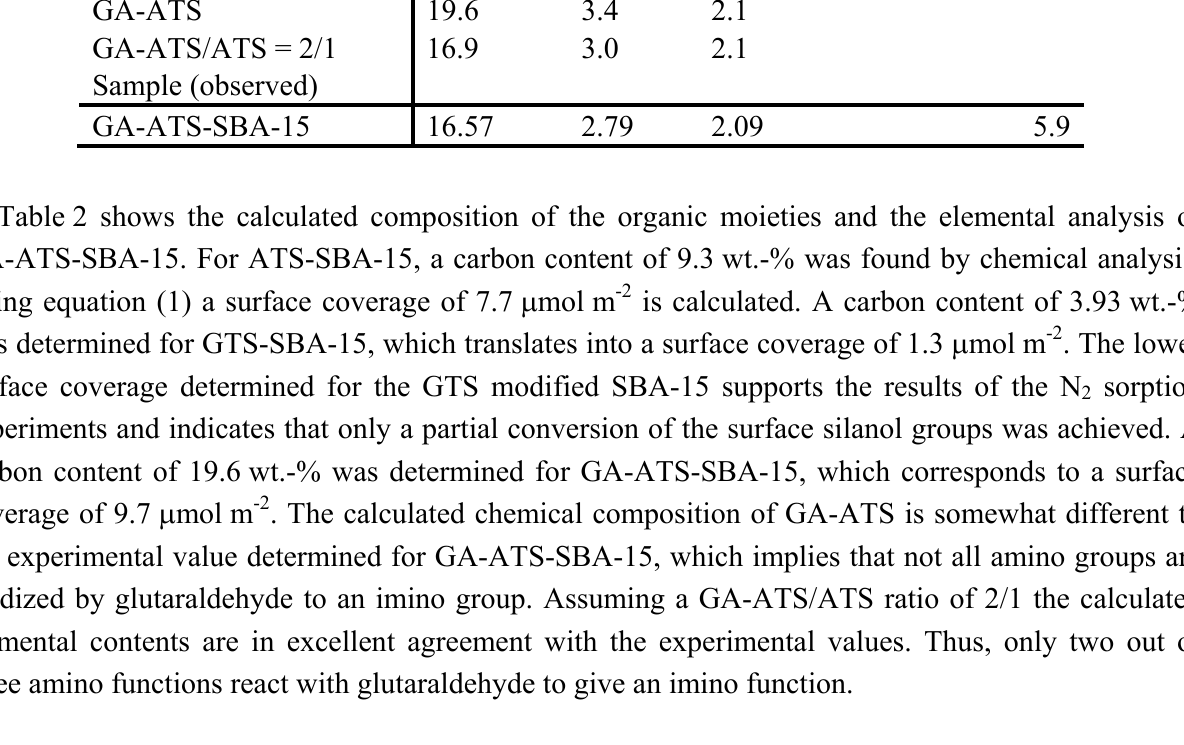
Figure 3. DRIFT spectra of SBA-15, ATS-SBA-15, GTS-SBA-15 and GA-ATS-SBA-15. The suffix -130 refers to the synthesis temperature of the parent